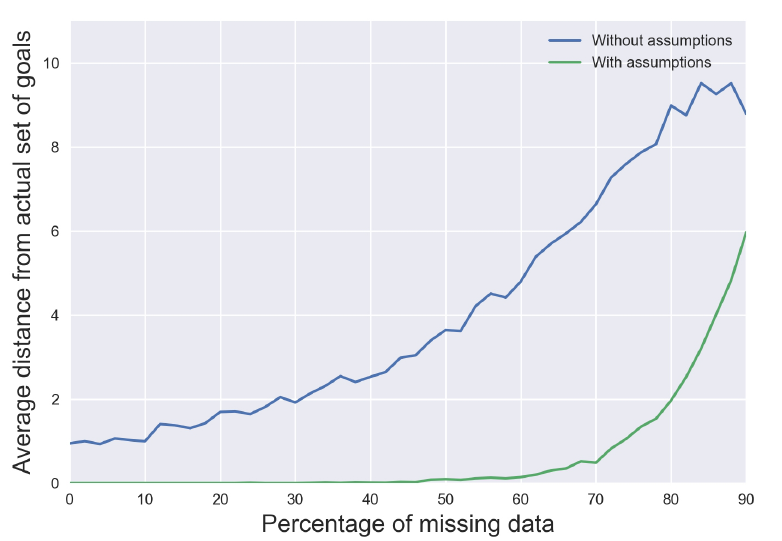
Figure 16. Comparison of the average syntactic distance from the actual goals in function of the percentage of missing data with and without assumptions on the